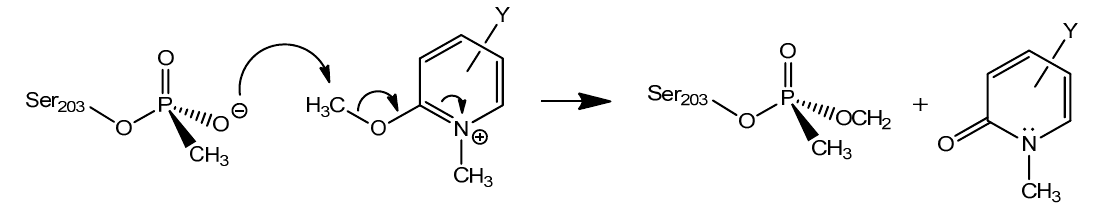
Figure 14. Proposed resurrection process for aged AChE.